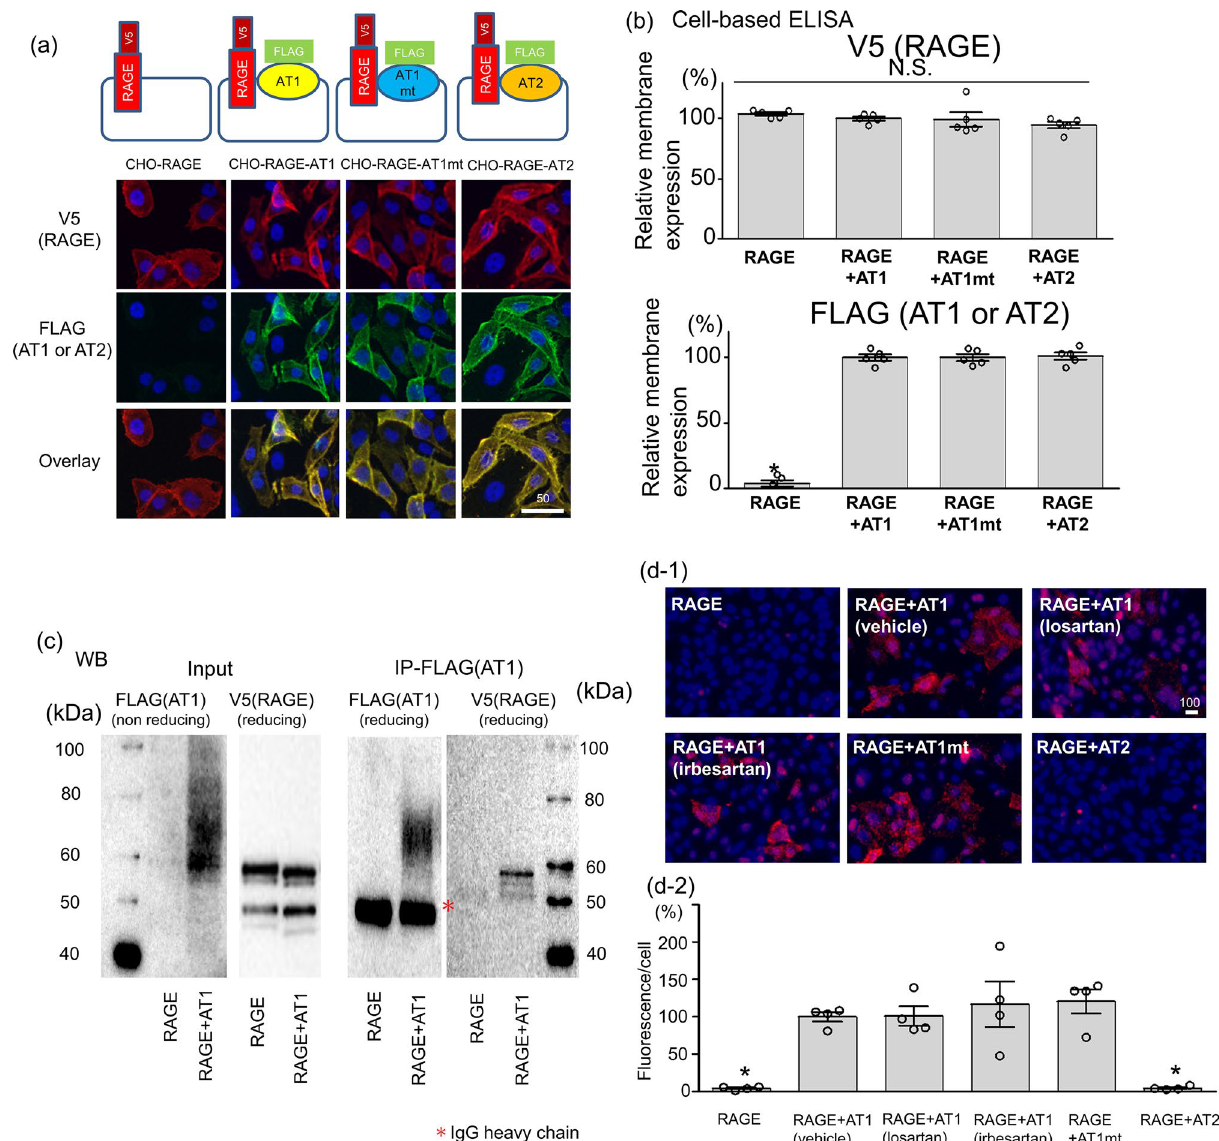
Figure 1. Physical interaction between RAGE and AT1 in transgenic CHO cells. ( a ) Immunofluorescence of CHO cells stably expressing V5-tagged RAGE alone or V5-tagged RAGE with FLAG-tagged AT1, FLAG- tagged AT1 mutant (AT1mt), or FLAG-tagged AT2 using anti-V5 or anti-FLAG antibody. Scale bar (μm) The red image indicates positive RAGE on CHO cells and the green images indicates positive AT1/AT1mt/AT2 on CHO cells. ( b ) Quantification of membrane-expressing V5-tagged RAGE, and FLAG-tagged AT1, AT1 mutant or AT2 by cell-based ELISA. Absorbance in CHO-RAGE-AT1 was normalized to 100% (number(n) = 5, each). * p < 0.01 vs CHO-RAGE-AT1. ( c ) Immunoprecipitation of membrane proteins with Anti-FLAG antibody followed by immunoblotting with Anti-FLAG antibody or anti-V5 antibody. Full-length blots are presented in Supplementary Fig. 1(d-1,2) In situ PLA performed under non-permeabilized condition using antibodies for mouse anti-V5 antibody and rabbit anti-FLAG antibody. Treatment with 10 μM losartan (AT1 blocker, ARB) or 10 μM irbesartan (ARB) was carried out for 24 h. The red fluorescence indicates the membrane proximity of V5-tagged RAGE and FLAG-tagged AT1/AT1mt/AT2 (< 30–40 nm). The graph indicates fluorescence/number of nuclei (% of that in CHO-RAGE-AT1 with vehicle treatment) (n = 4, each). Scale bar (μm); * p < 0.01 vs CHO- RAGE-AT1 with vehicle treatment. The differences were determined by one-way ANOVA with Bonferroni